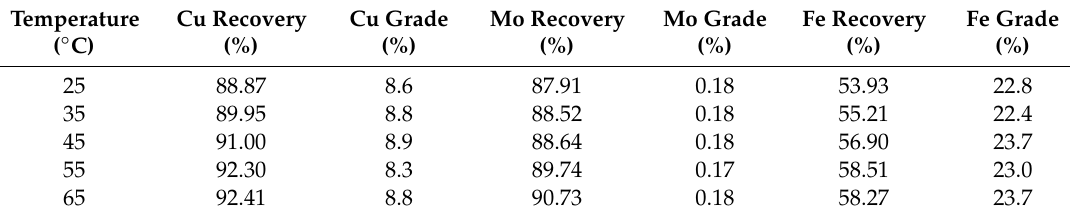
Figure 6. Lab flotation tests results: multi-element recovery at different temperatures. Table 2. Lab flotation recovery and grade details.